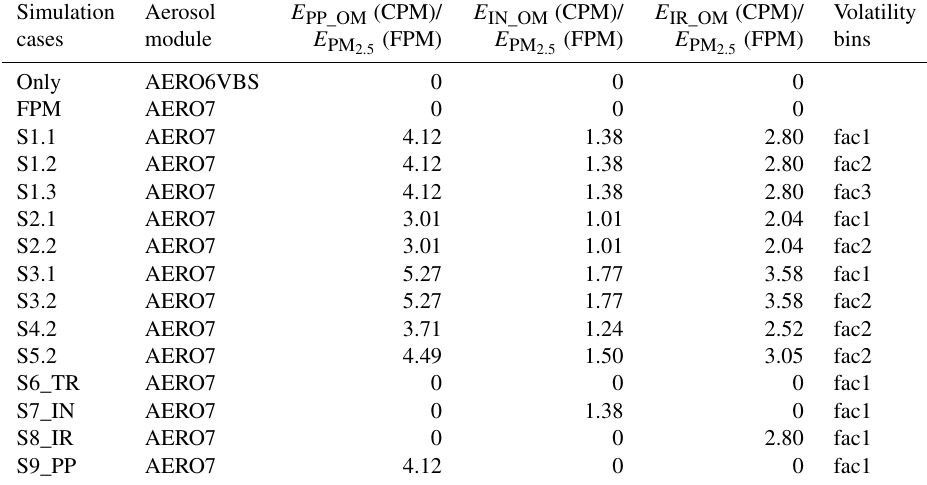
Table 4. Simulation case design. PP, IN, IR, and TR denote the power plant, industry combustion, steel, and transportation source sectors, respectively. Three kinds of scaling factors for the five volatility bins of organic CPM are tested: fac1 (0, 0.18, 0.14, 0.18, and 0.5), fac2 (0, 0.66, 0.40, 0.51, and 1.43), and fac3 (0, 0.42, 0.27, 0.345, and 0.965), the latter of which is the average of fac1 and fac2. Simulation Aerosol E PP_OM (CPM)/ E IN_OM (CPM)/ E IR_OM (CPM)/ Volatility cases module E PM (FPM) bins 2 . 5 Only